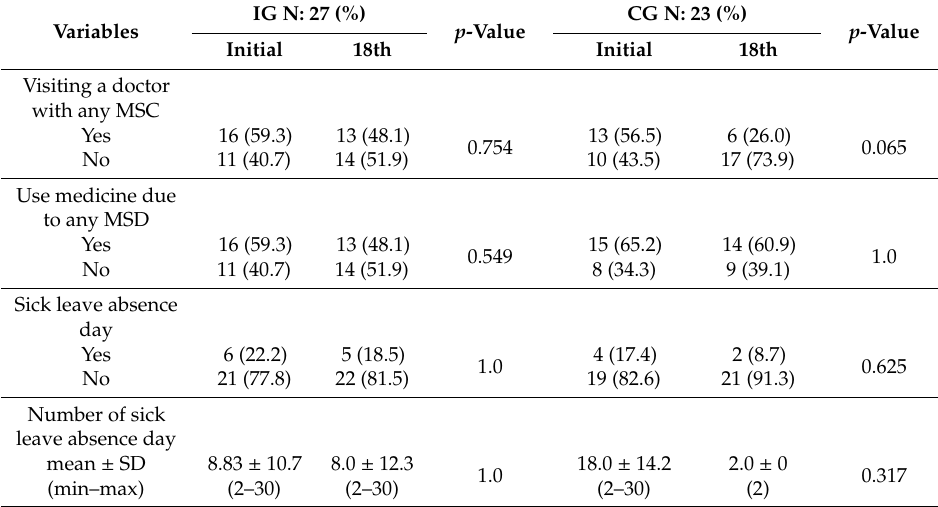
Table 4. Within-group analysis of nurses’ scores (before and after the intervention).